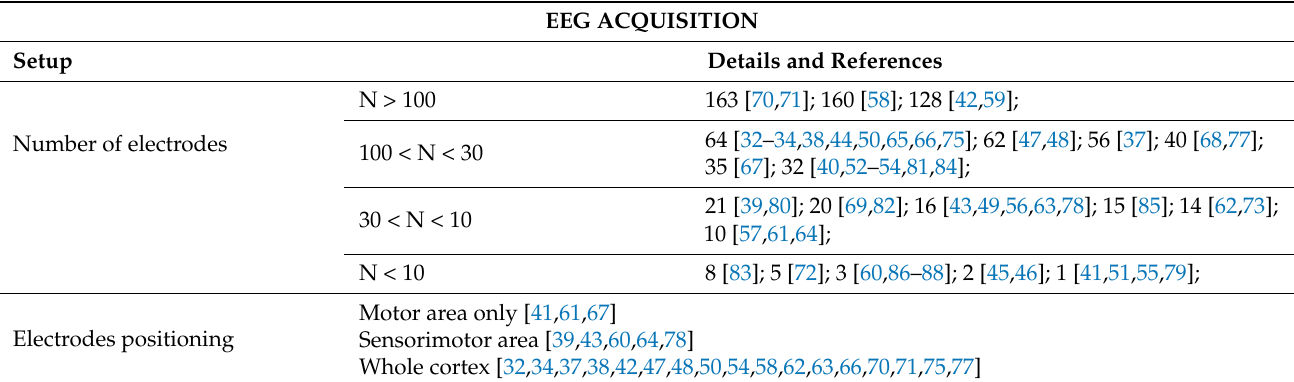
Table 4. Setup for signal